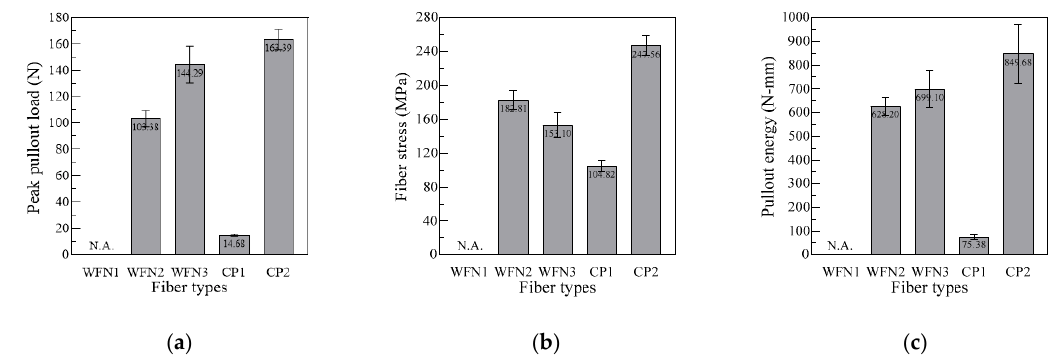
Figure 6. Effect of using different fiber types on the pullout resistance: ( a ) Peak pullout load; ( b ) Fiber stress; ( c ) Pullout energy.